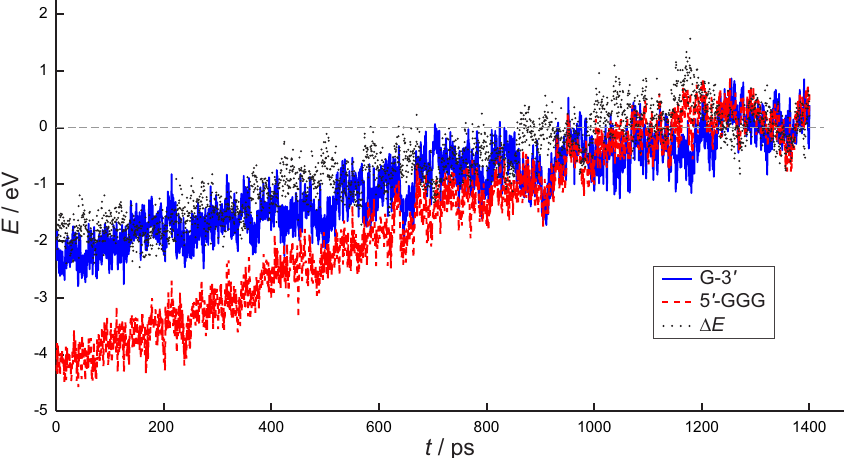
Figure 7. HOMO energy (eV) of 5 (cid:48) -GGG nucleobase stack (red dashed line) and G-3 (cid:48) nucleobase (blue line) together with their difference ( ∆ E , black dots) for the 5 (cid:48) -GGGTG-3 (cid:48) double strand immersed in a box consisting of ca . 15,000 water molecules and including counterions. Average values over 3 simulations are reported. The hole is initially ( t = 0) localized on